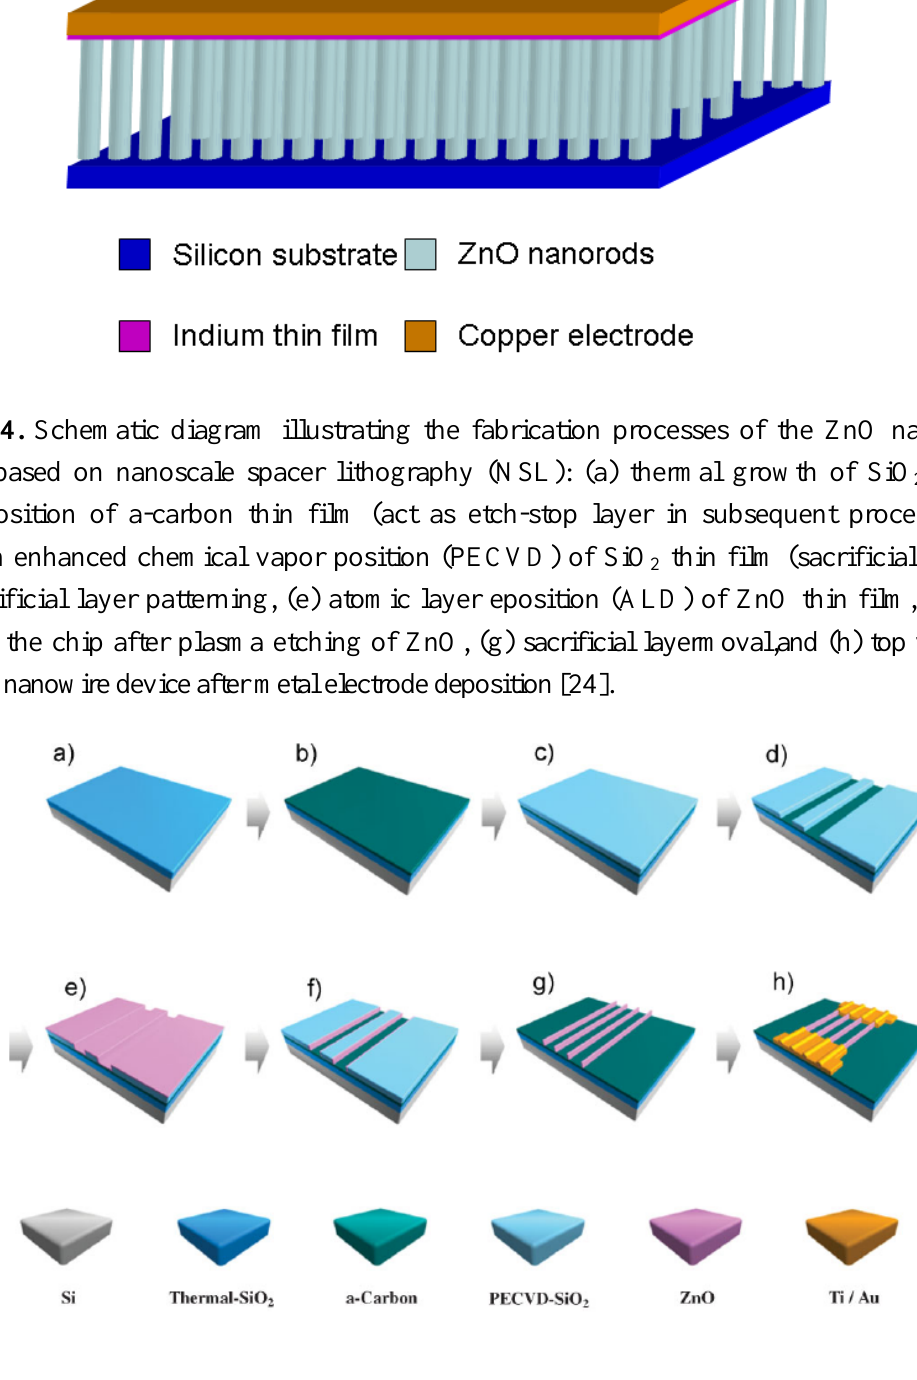
Figure 3. The schematic of the ZnO nanorod array sensor.